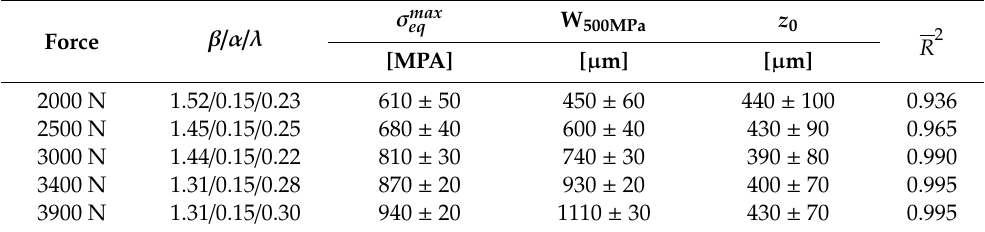
Table 2. Fit values of the internal stress distribution σ eq (0, z ) for Equation (3) during loading.